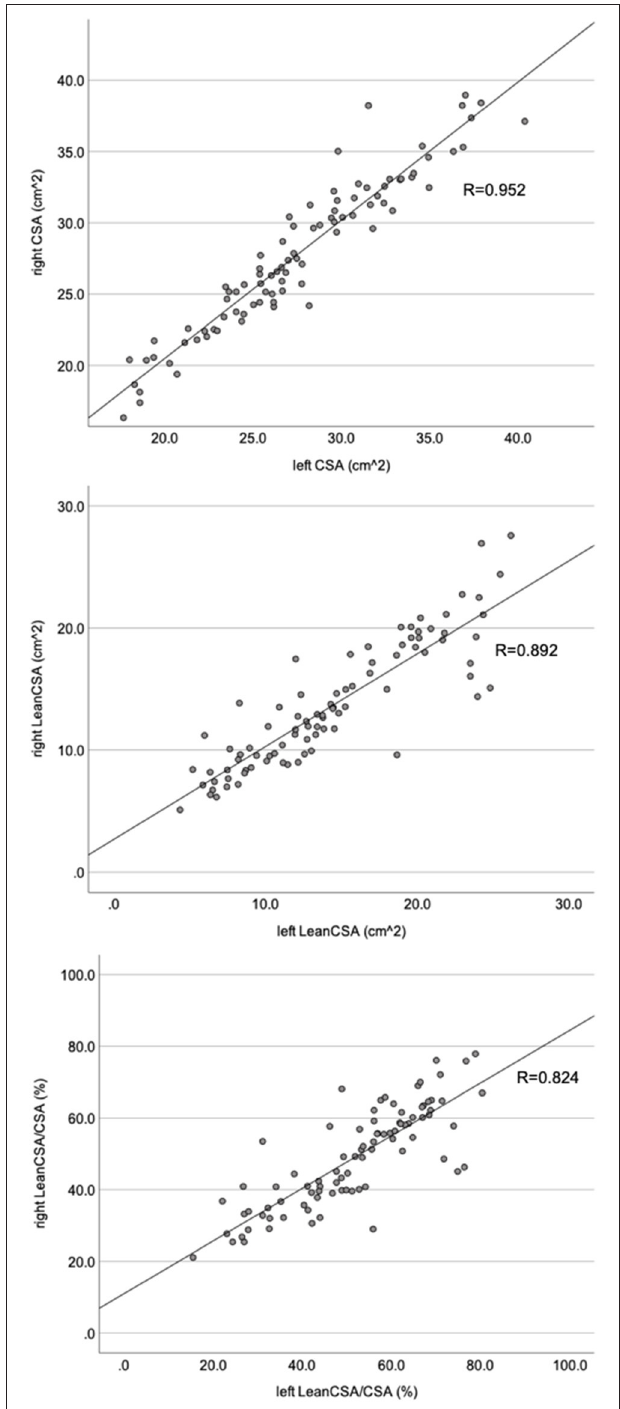
FIGURE 6 | Scatter plots comparing the left and right sides of the paraspinal muscle cross-sectional area (CSA; top), lean muscle cross-sectional area (LeanCSA; middle) and the ratio between LeanCSA and the paraspinal muscle cross-sectional area (LeanCSA/CSA; bottom). R , Pearson’s correlation